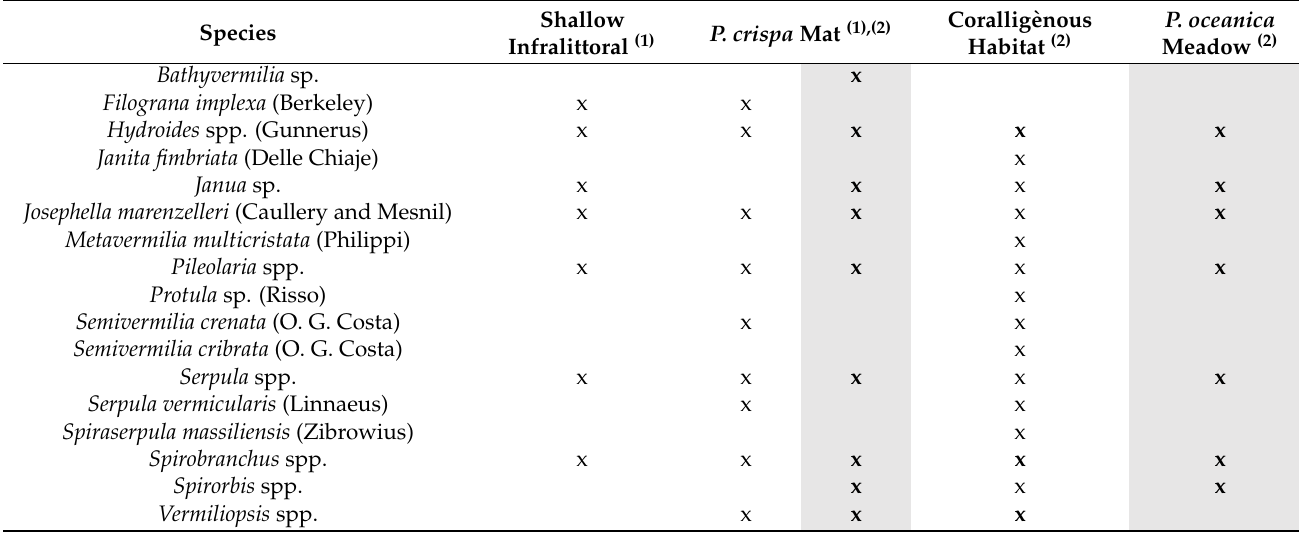
Table 3. Serpulidae species found in the samples compared to other habitats, x indicates presence; Data from (1) Casoli et al. (2016) [19] and (2) this study (grey columns). Species